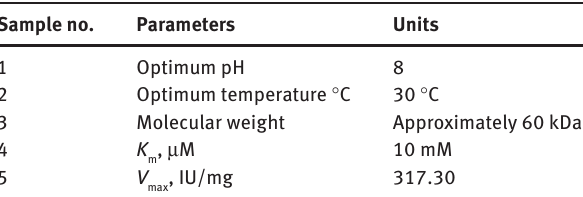
Table 2: Characteristics of purified pterin deaminase from Saccha- romyces cervisiae . Sample no.